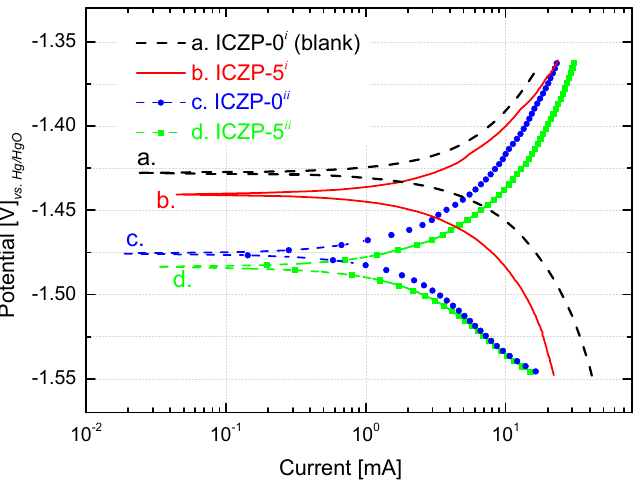
Figure 2. Tafel plot from potentiodynamic polarization curves (0.5 mV s − 1 ) of uncoated Zn particles (ICZP-0) and 5 wt. % ionomer-coated (ICZP-5) in 6.6 M KOH ( i : blank) and modified ( ii : 4s-2) aqueous alkaline electrolytes.